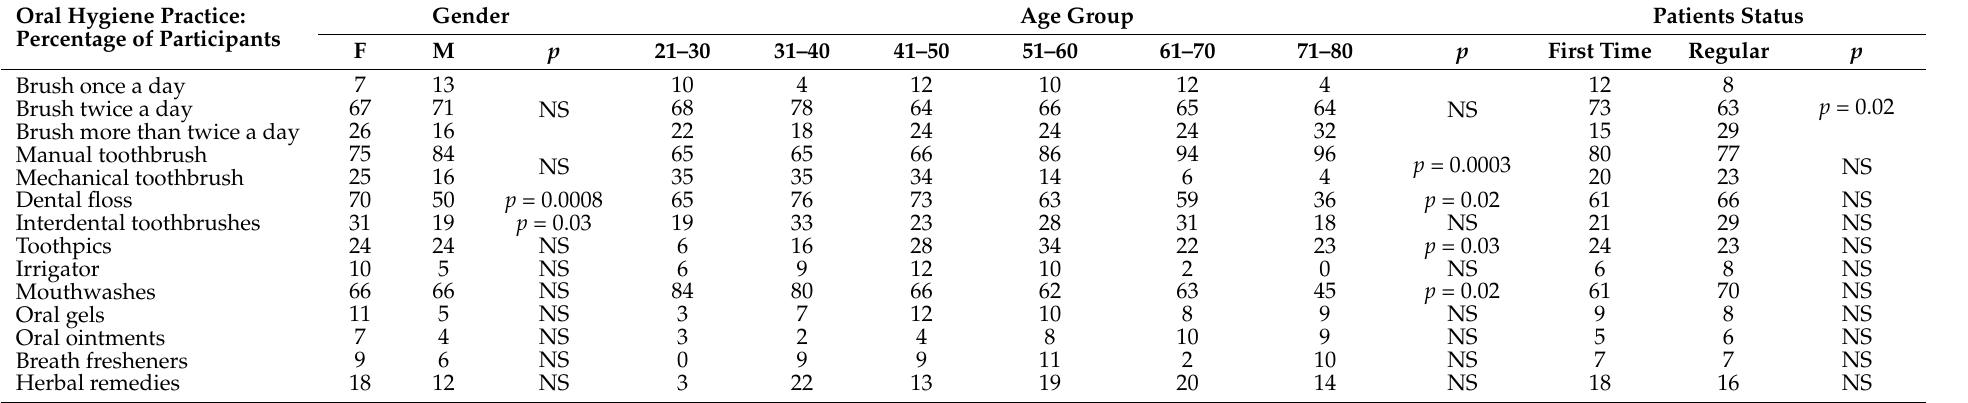
Table 6. Self-reported oral hygiene in different age, gender and outpatient clinic status patients (data as a